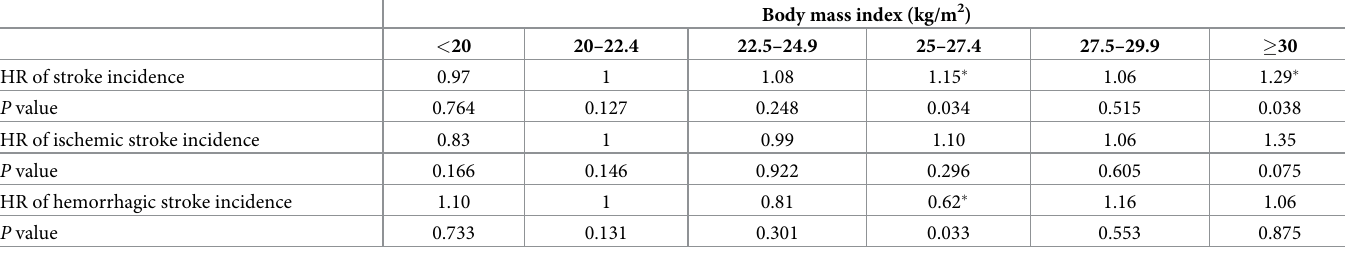
Table 4. Hazard ratios for stroke risk by different categories of body mass index among men with diabetes mellitus after excluding patients who were diagnosed with a stroke less than three years after the baseline measurements.